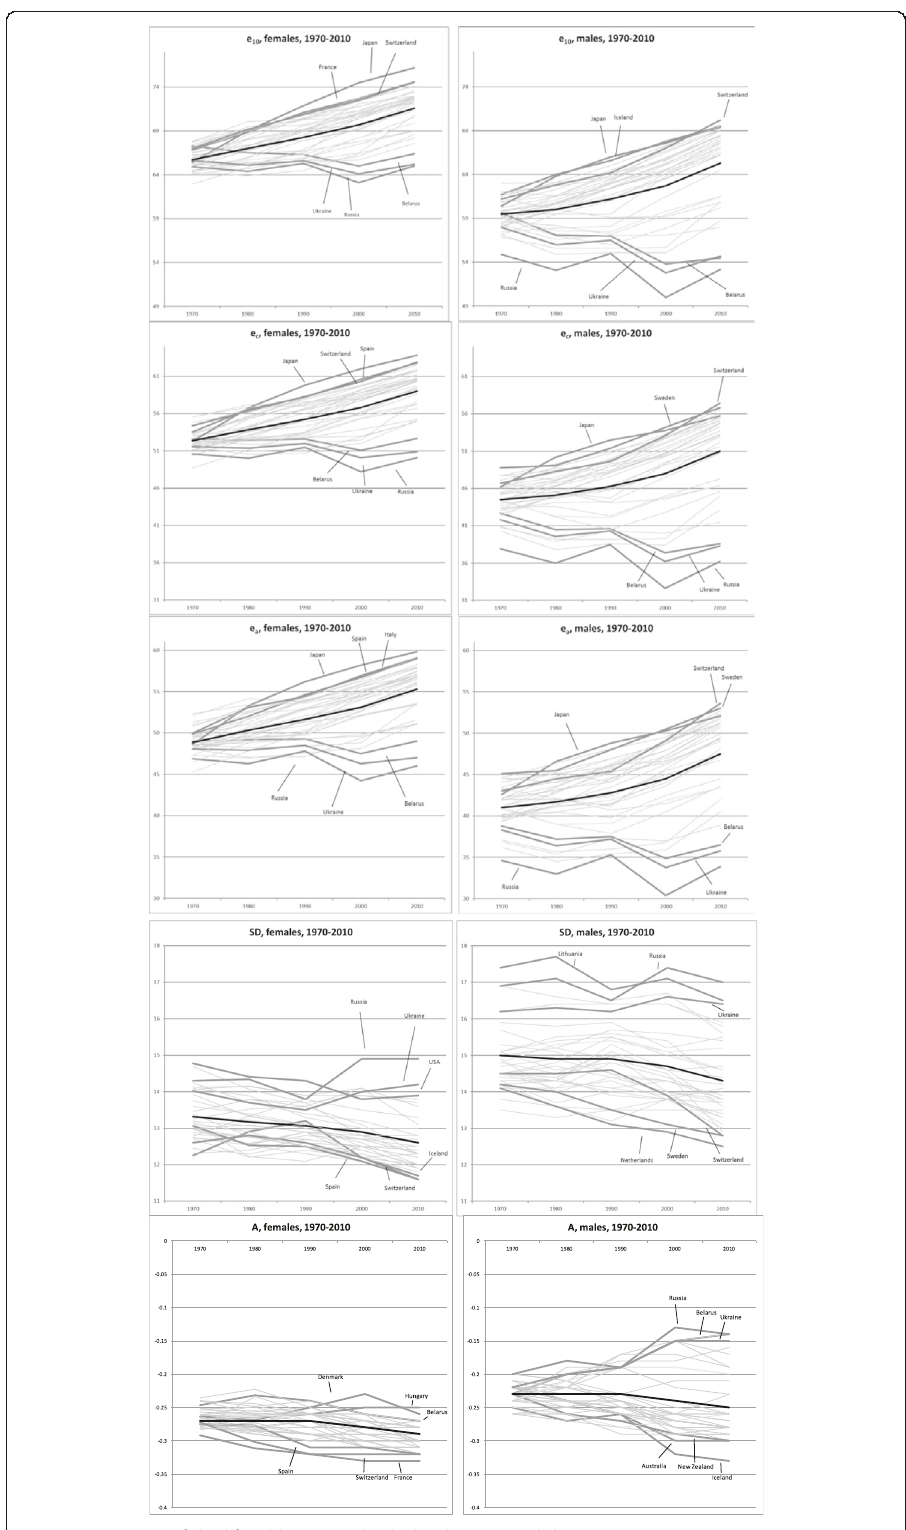
Fig. 2 Parameters of the life-table age-at-death distributions and the summary measures ( e 10 , e C , e A ) in 35 developed countries, by sex, selected years 1970 –